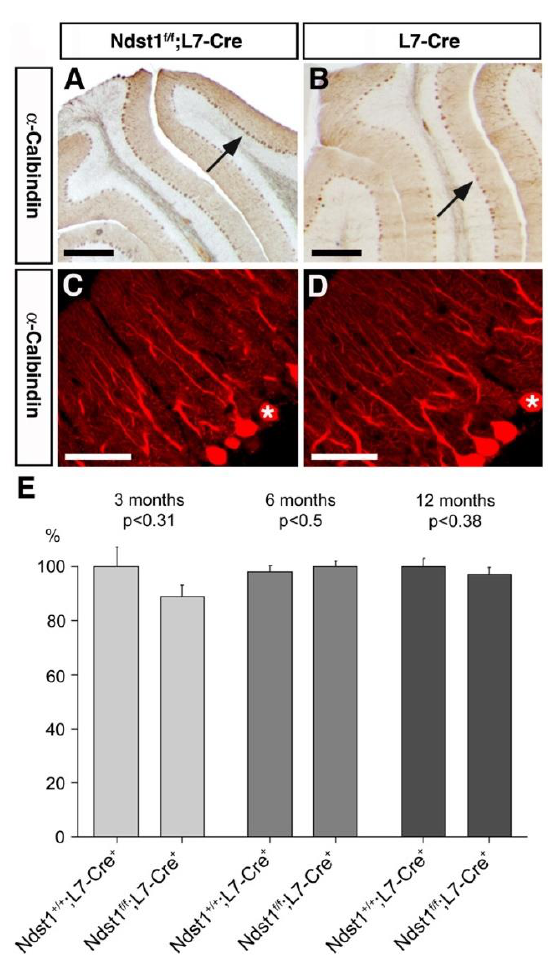
Figure 3. Cerebellar morphology and Purkinje cell number and morphology are unchanged in Ndst1 f/f ;L7-Cre + mutant mice. Calbindin staining reveals similar cerebellar morphology and Purkinje cell numbers when comparing ( A ) Ndst1 f/f ;L7-Cre + and ( B ) L7-Cre + mice. Scale bars: 200 μm. Purkinje cell morphology is also unaltered ( C , D ). Scale bars: 50 μm. ( E ): Purkinje cell number is unaffected after 3 months, 6 months and 12 months. Cells were counted and plotted as relative % of the control number.